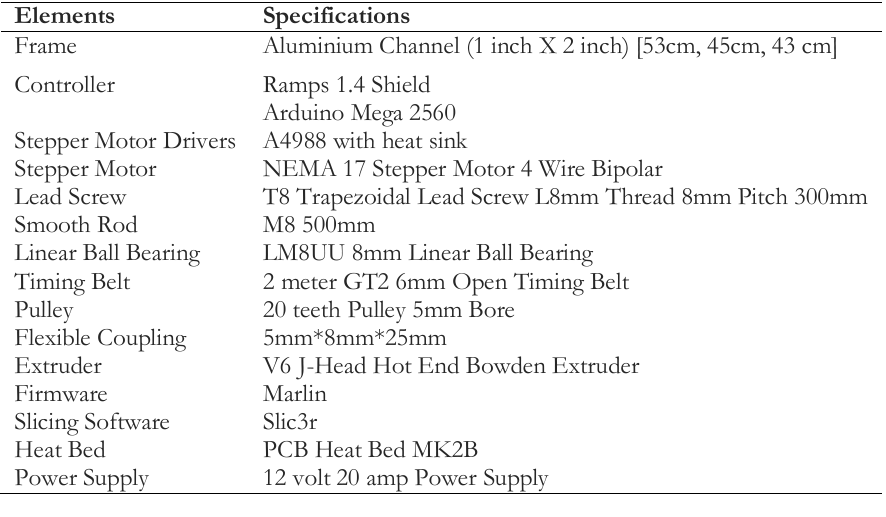
Table 1. Specification of the fabricated 3D printer including hardware and software.